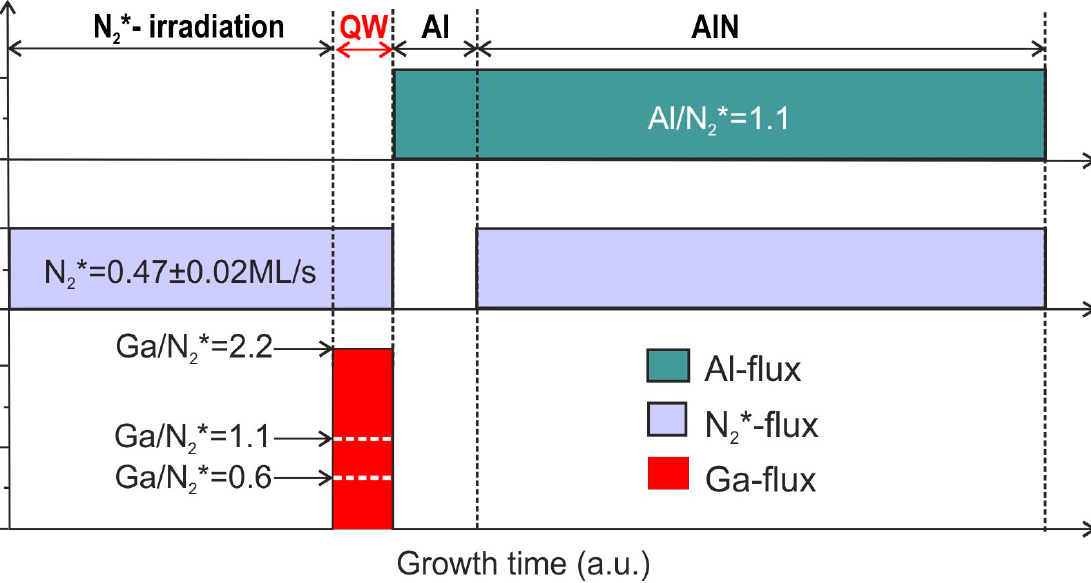
Figure 1. Scheme of the growth of GaN 1.5 /AlN 16 QW structures at various Ga/N 2 * flux ratios determined by the Ga fluxes marked by dashed lines in their time diagrams.